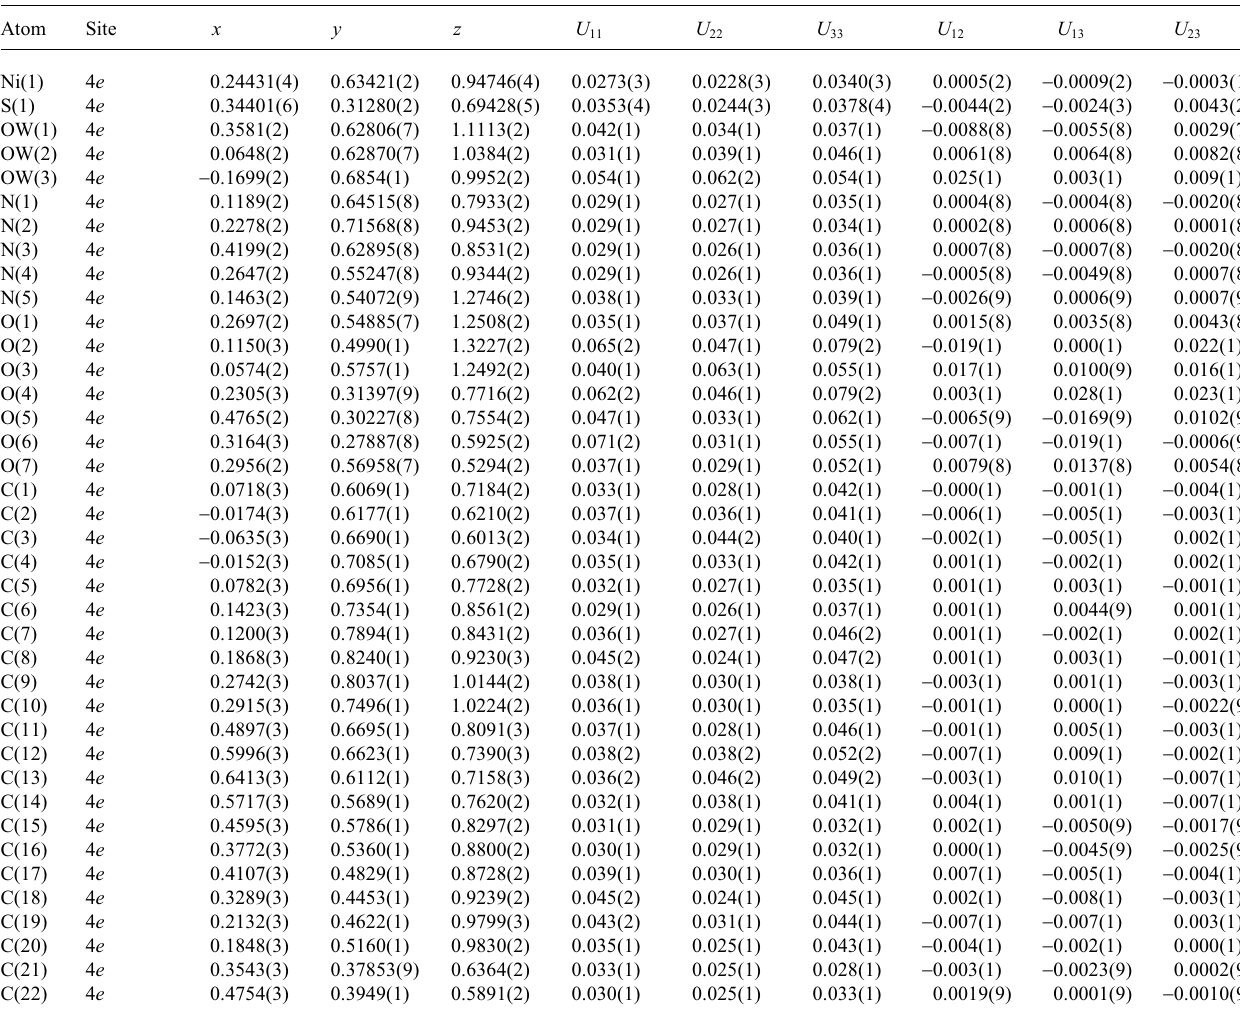
Table 3. Atomic coordinates and displacement parameters (in Å 2 ).